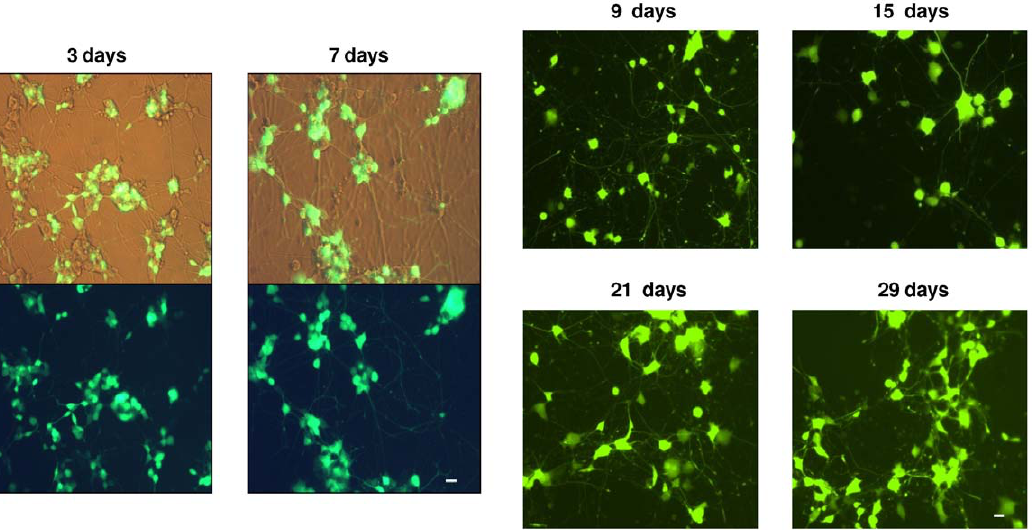
Figure 5. RT43.2GFP gammaretroviral vector transduction into differentiated PC12 cells: longevity of expression. PC12 cells were grown in 4-well Matrigel-coated chamber slides, treated with NGF for 5 days, and exposed to gammaretroviral vectors in the continuous presence of NGF. Representative examples of NGF-treated PC12 cells exposed to RT43.2GFP vectors were photographed with a 20 6 objective, 3 days and 7 days after exposure to viral vectors using phase contrast and a FITC filter. Representative fields of differentiated PC12 cells 9, 15, 21, and 29 days after exposure to RT43.2GFP retroviral vectors were photographed using a FITC filter. Scale bars=20 m m.